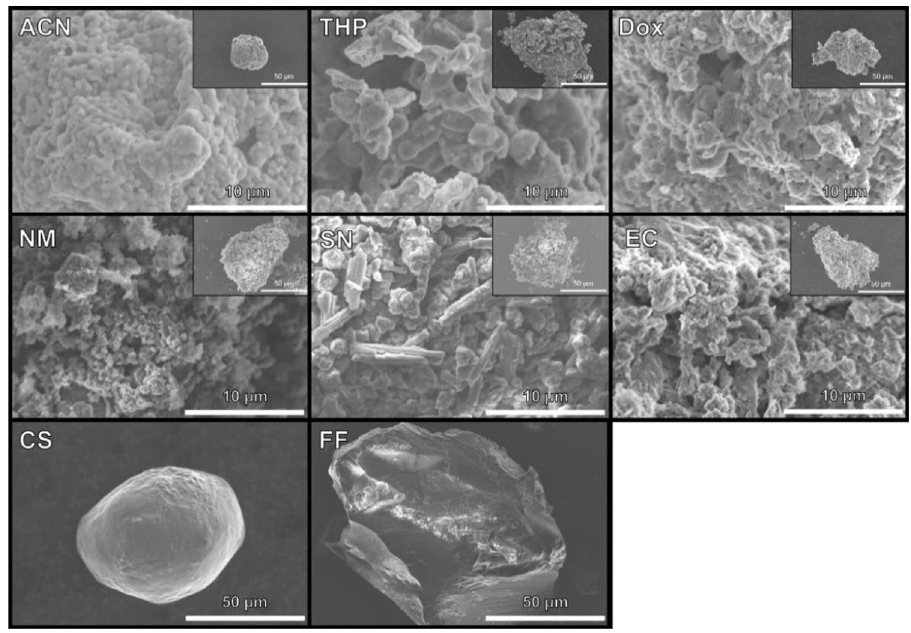
Figure 3. SEM images of 70Li 2 S–30P 2 S 5 synthesized via ACN, THP, Dox, NM, SN, EC, CS, and FF solvents.